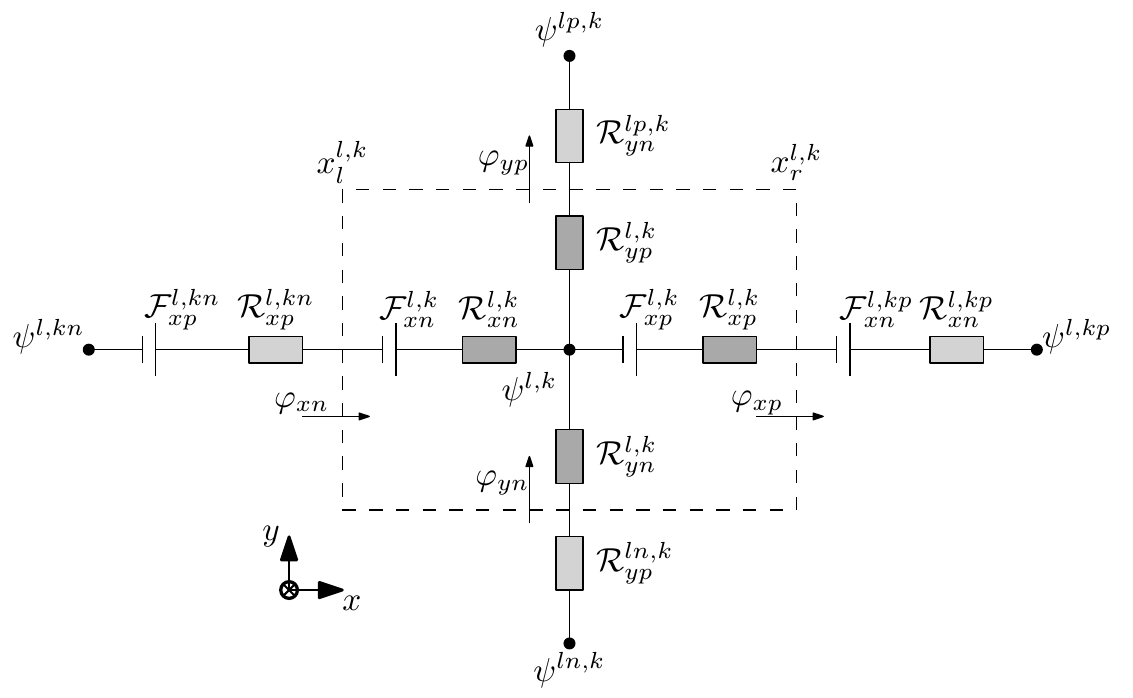
Figure 4. Single MEC